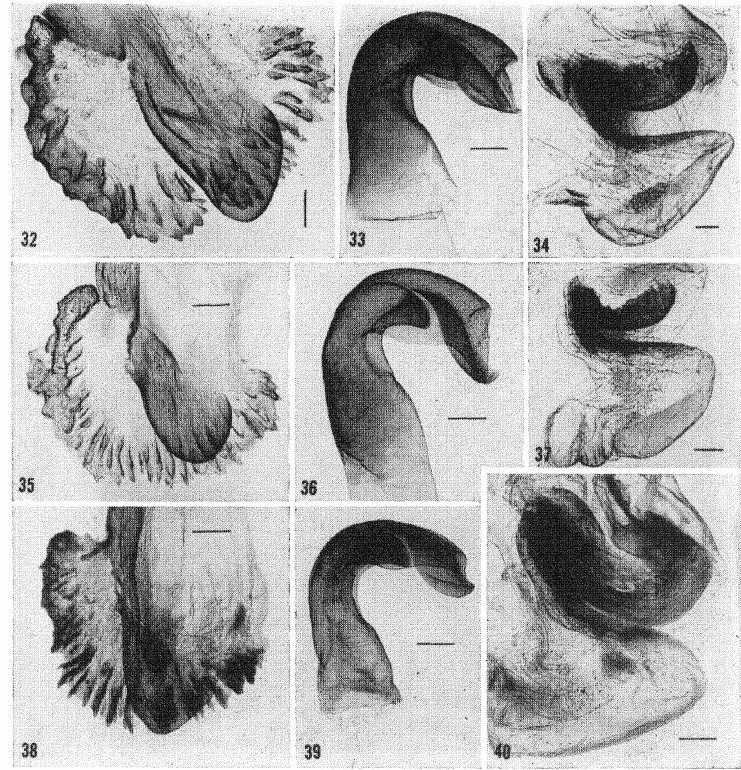
Figs. 32-40. 32-34. (62 USNM). Xrc.himandrita tessellata. Canal Zone, Panama (det. Hebard). 35-37. (61 USNM). X. tessellata. (from specimen shown in Fig. 2), 38-40. (11 ANSP). drchimandrita rnarmorata. (from specimen shown in Fig. 1). (scale 0.3